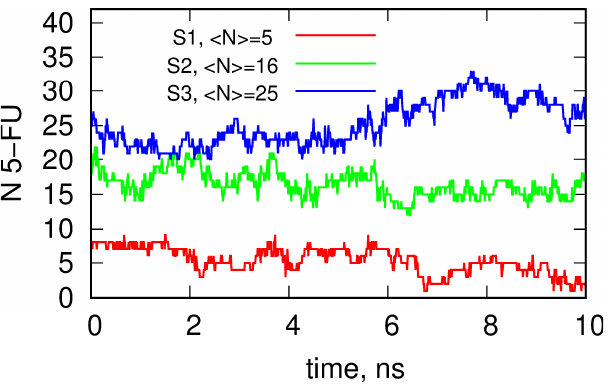
Figure 6. The instantaneous number of 5FU molecules bound to the dendrimer as a function of time obtained in the last 10 ns of simulations.